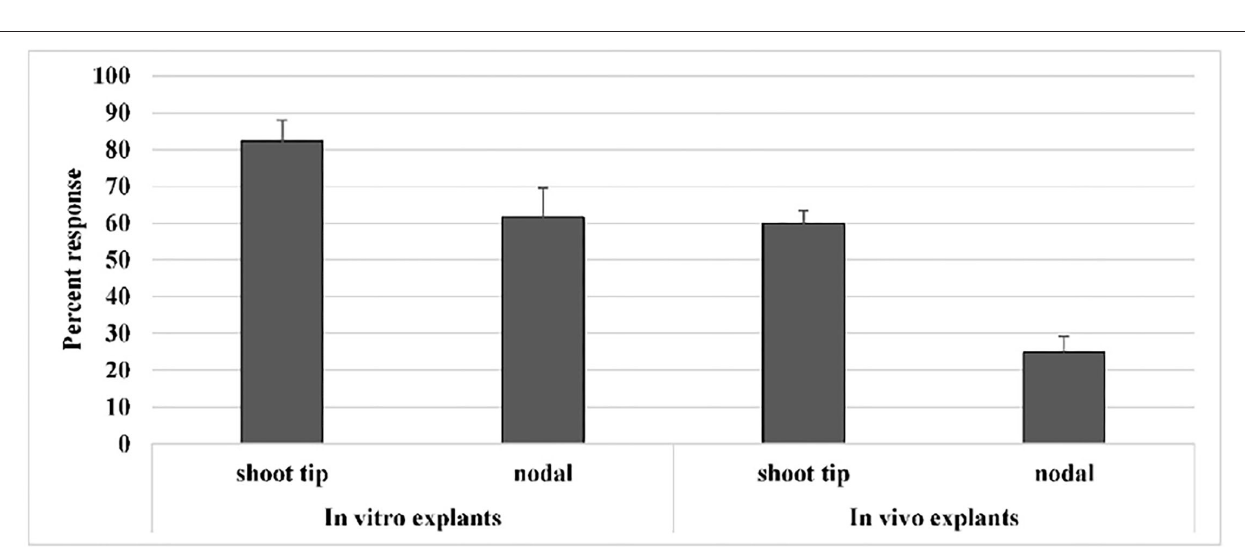
Synthesis of Zinc Oxide and Copper